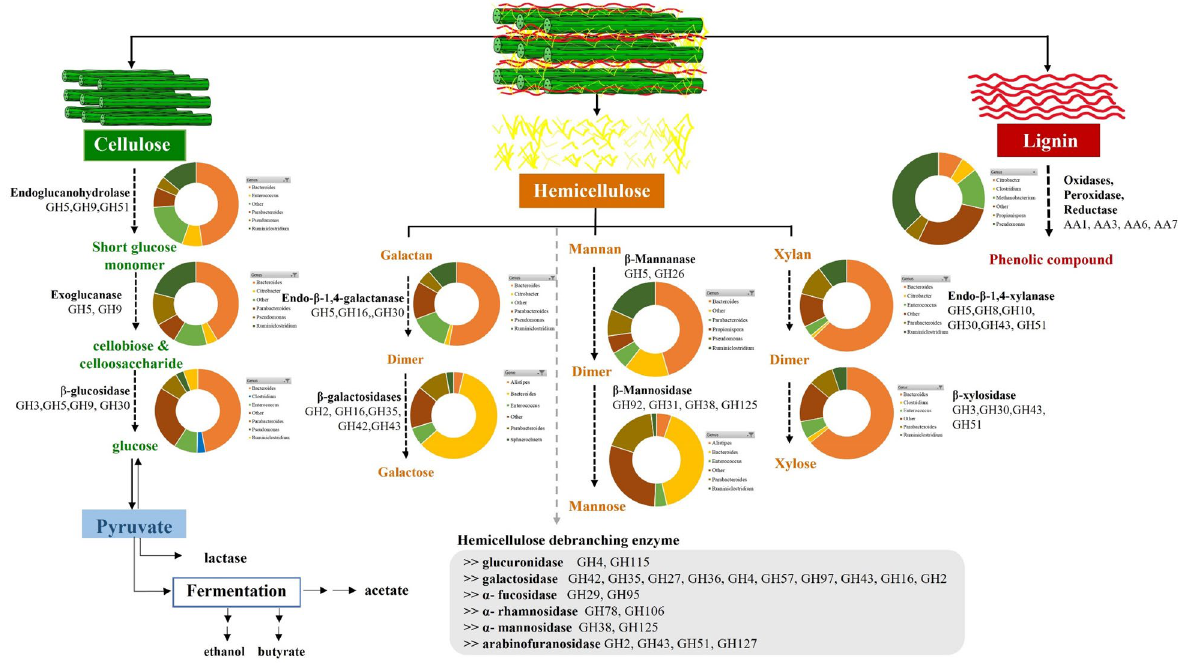
Figure 6. Lignocellulosic degradation pathway, related enzymes, and microorganisms found in sugarcane bagasse metagenome. Colored pie charts show the number of major bacterial phyla microorganisms involving different steps of biomass degradation. (I) Cellulose (green): Full enzymatic hydrolysis of cellulose requires the cooperation of endoglucanase [3 glycoside hydrolase (GHs)], exoglucanase (2 GHs), and β-glucosidase (4 GHs); (II) Hemicellulose main chain (orange): degradation of the hemicellulose linear β-1,4-linked main chain requires the action of endo-β-1,4-xylanase (6 GHs) and β-xylosidase (4 GHs) for β-1,4-xylan, and β-mannanase (2 GHs) for β-1,4-mannan, and β-galactanase (3) for β-galactosidase. (III) debranching enzymes (gray): debranching enzymes for degradation of complex substituted xylan included ten GHs galactosidase, two GHs α-fucosidase, two GHs α-rhamnosidase, two GHs α-mannosidase, four GHs arabinofuranosidase and debranching enzymes for pectin included two GHs glucuronidase. (IV) lignin (red): KKU-MC1 exhibited with lignin degradation activity with four AAs; AA1, AA3, AA6, and